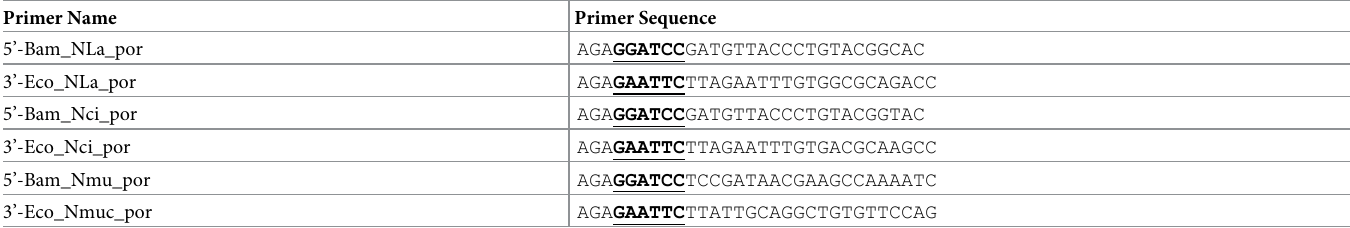
Table 1. Primers used to amplify porB genes from N . cinerea , N . lactamica , and N . mucosa genomic DNA. Primer